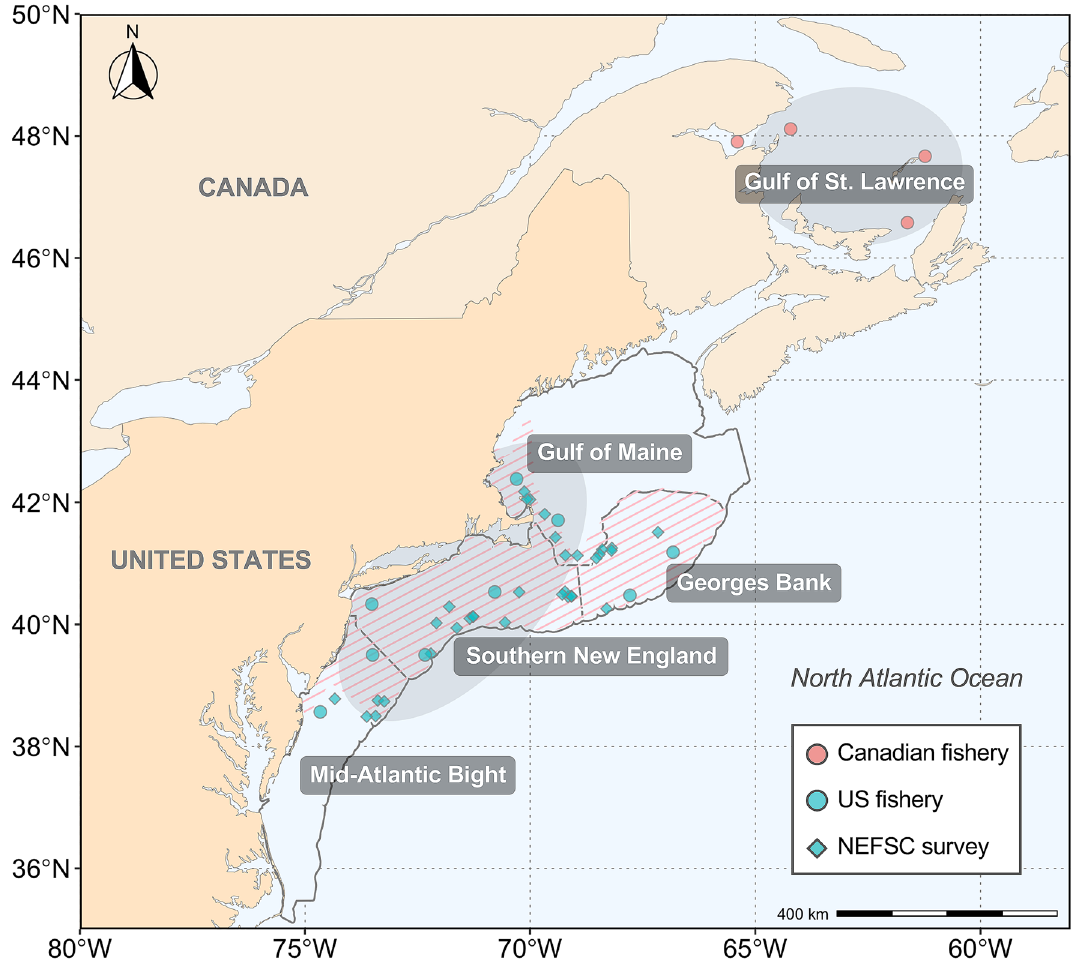
Figure 1. Map of the western North Atlantic Ocean illustrating sampling areas and spawning sites of the Northwest Atlantic mackerel. Sample locations are shown for the US winter fishery, the Canadian summer fishery, and the Northeast Fisheries Science Center (NEFSC) fishery-independent bottom trawl survey. Shaded ellipses in the Gulf of St. Lawrence and US continental shelf depict principal spawning sites for the northern and southern contingents. Hatched areas in the US continental shelf illustrate principal contingent mixing regions during winter. The map was created in R using the ggplot2 package version 3.3.2 URL: https:// ggplo t2. tidyv erse. org 73